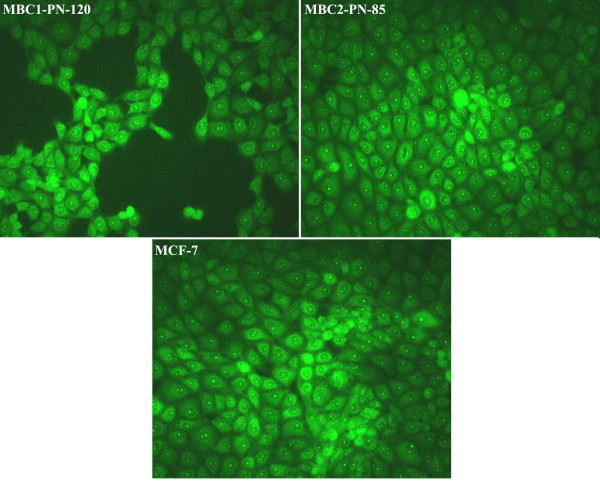
Expression of ER in MBC1 and MBC2 Cell Lines, with MCF-7 as a Positive Control. The expression of ER was shown in the MBC1-PN-120, MBC2-PN-85 and MCF-7 (as a positive control) with a localised nuclear staining pattern. Magnification, 20X.